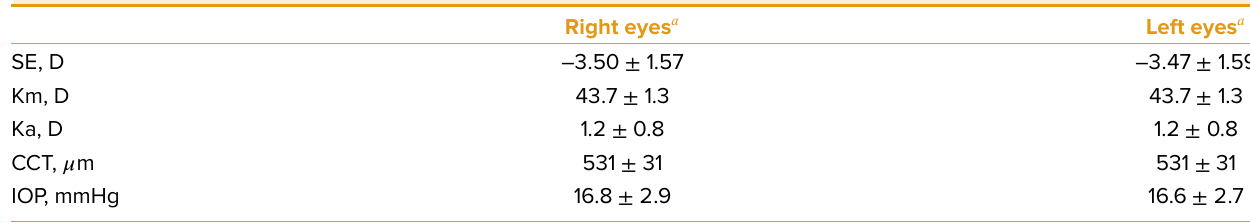
Table 1. Baseline characteristics of the study cohort